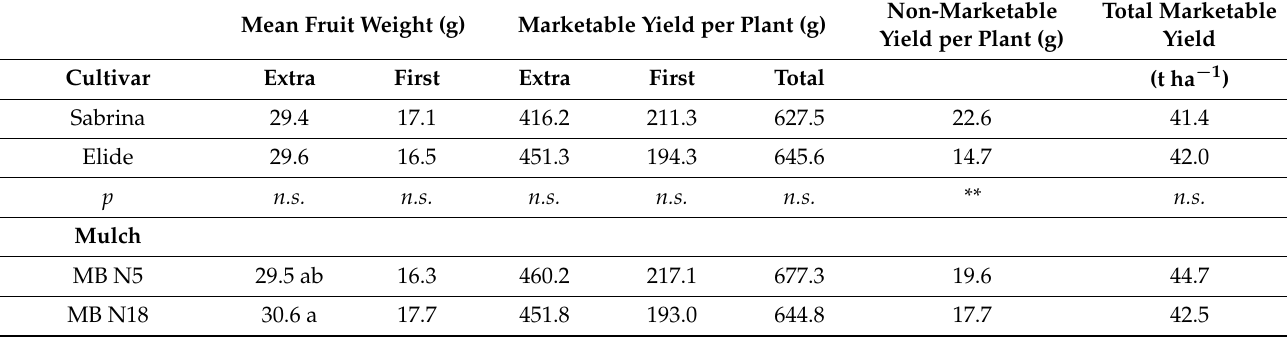
Table 1. Strawberry cultivar, mulch type, and cultivar × mulch type interaction effects on mean fruit weight, mean marketable yield per plant, mean not marketable yield per plant, and total marketable yield per hectare.